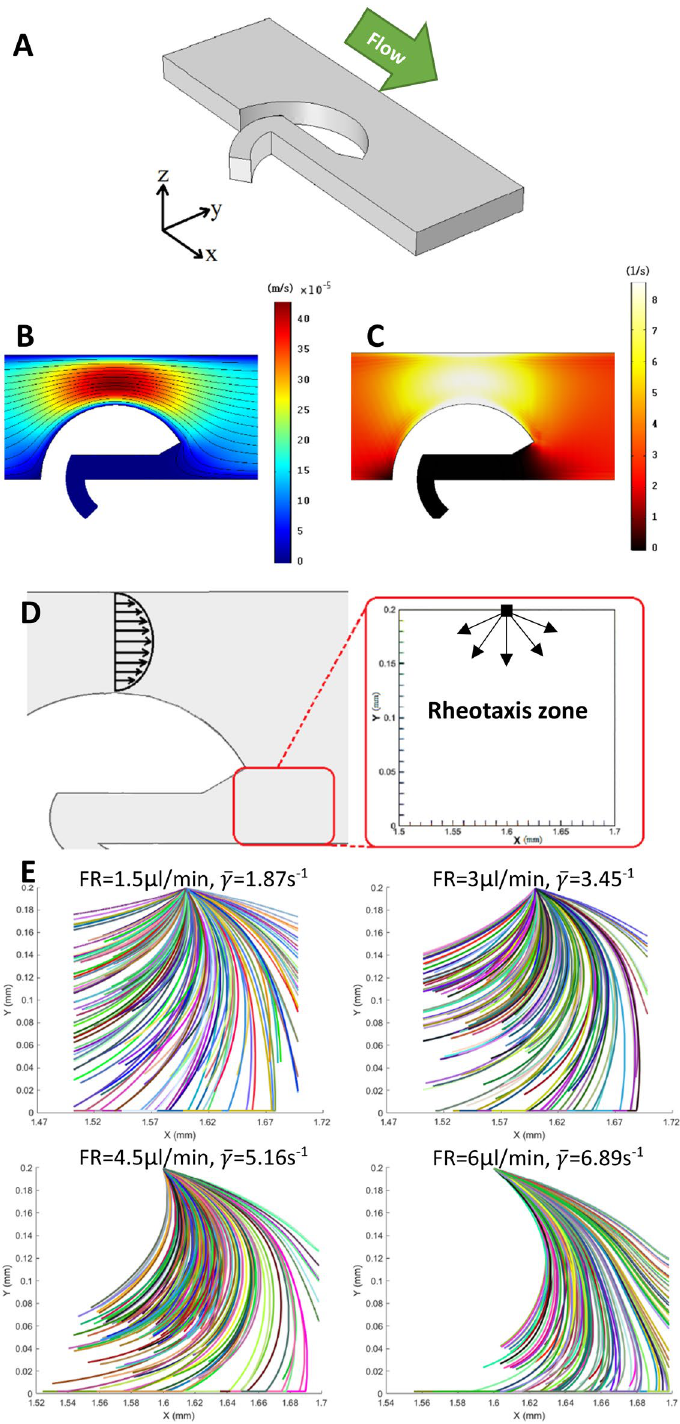
Figure 2. Simulation results of the velocity field, shear rate in the vicinity of the obstacles for flow rate 3 μl.min −1 , and sperm trajectories inside the rheotaxis zone. ( A ) The geometry of a section of the main channel near one obstacle. ( B ) Velocity field of the sample medium over a cutplane with a 50 μm distance from the top surface with a maximum of 450 μm.s −1 and a minimum of zero. ( C ) The shear rate distribution over a cutplane with a 10 μm distance from the top surface with a maximum of 8.4 s −1 . ( D ) A portion of the main microchannel and the hypothetical rheotaxis zone placed in front of the obstacle. The sperm are released into this zone from the top point shown. ( E ) predicted trajectories for motile sperm showing rheotactic behavior. The equations of sperm motion were solved for 150 sperm with a random initial velocity between 40–90 μm.s −1 and a random entrance angle into the rheotaxis zone between 0 and 180 degrees for injected flow rates starting from 1.5 to 6 μl/min. As the mean flow shear rate (flow velocity) inside the rheotaxis zone ( γ ) increases, the number of sperm capable of resisting flow and reorienting against the flow direction decreases. Part B, and C are obtained using COMSOL 40 . Part E is obtained using MATLAB 39